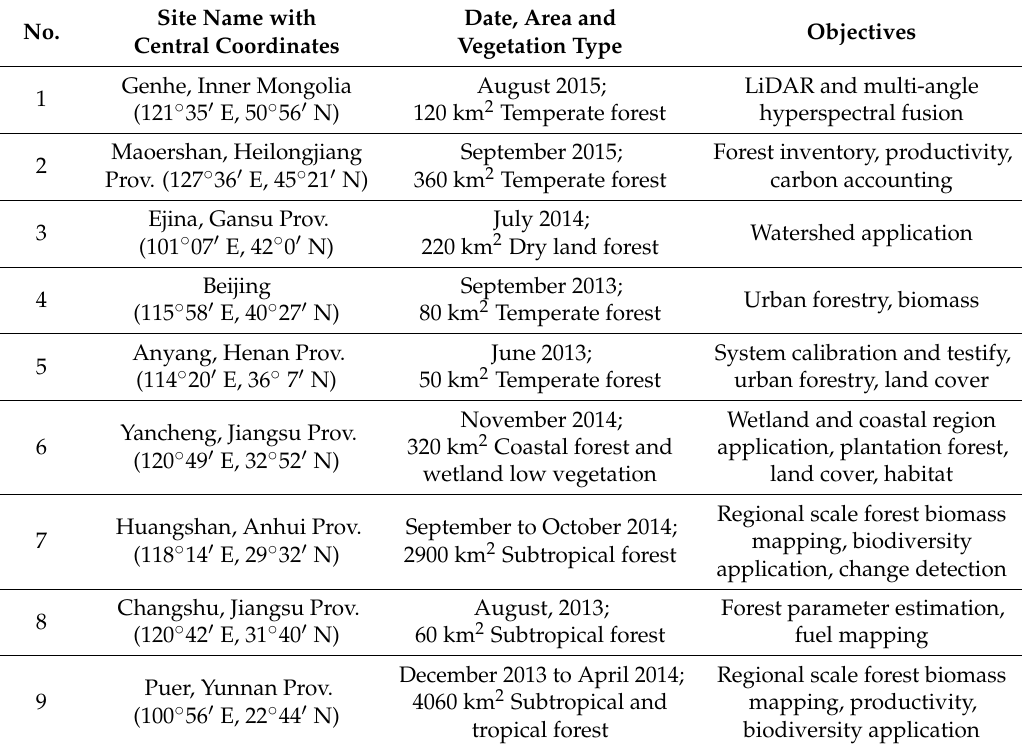
Table 2. General descriptions of CAF-LiCHy data coverage sites from 2013 to 2015. No.